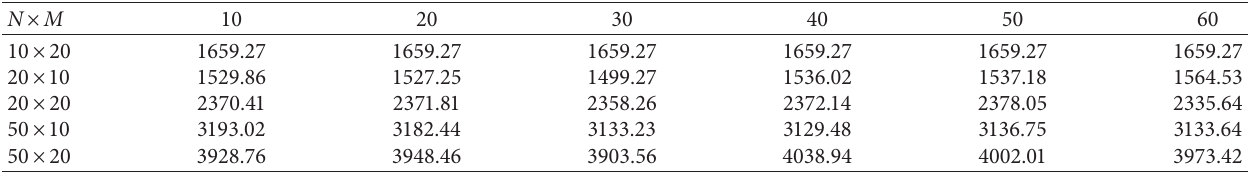
Table 2: The average value of makespan under different values of popsub num (unit: second). N × M